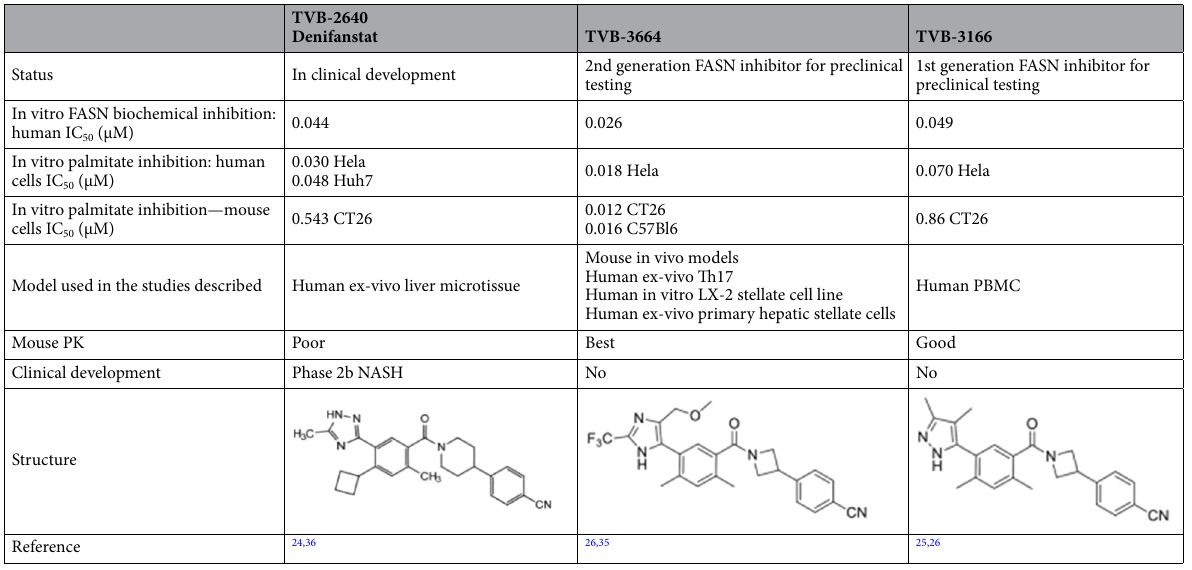
Table 1. Characteristics of FASN inhibitors TVB-2640 (denifanstat), TVB-3664 and TVB-3166.